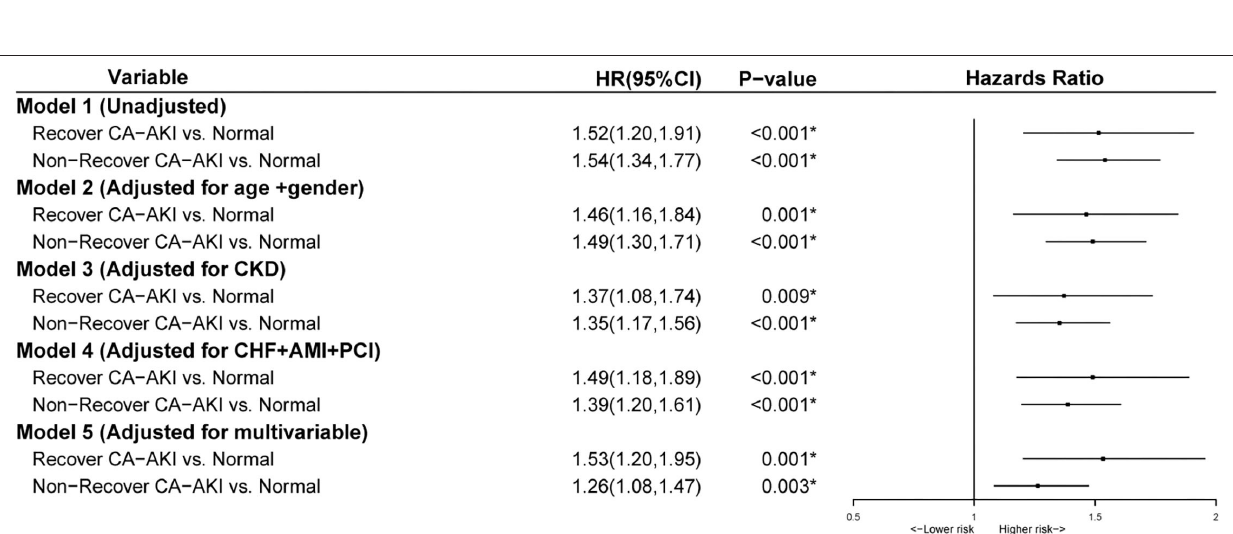
FIGURE 3 | Multivariable analysis for mortality stratified according to no contrast-associated acute kidney injury (CA-AKI), recovered CA-AKI, and non-recovered CA-AKI. Model 1: Unadjusted; Model 2: Adjusted for age>75 years and gender; Model 3: Adjusted for chronic kidney disease (CKD); Model 4: Adjusted for chronic heart failure, acute myocardial infarction (AMI), and percutaneous coronary intervention (PCI); Model 5: Adjusted for age>75 years, gender, diabetes mellitus, anemia, chronic heart failure, hypertension, CKD, albumin, PCI, contrast media volume, and AMI. * p < 0.05.